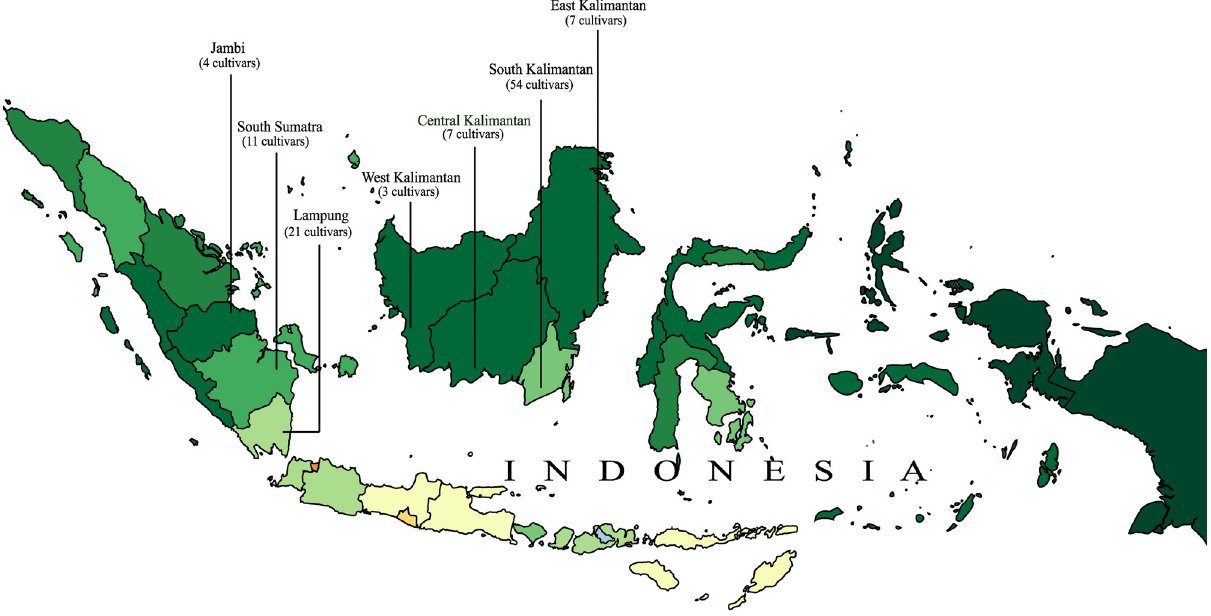
Figure 1. Map of Indonesia, showing the seven regions (provinces) where the 107 swamp rice accessions employed in this study were collected. Detailed information about the accessions (names, habitats) is listed in Table A1 in the